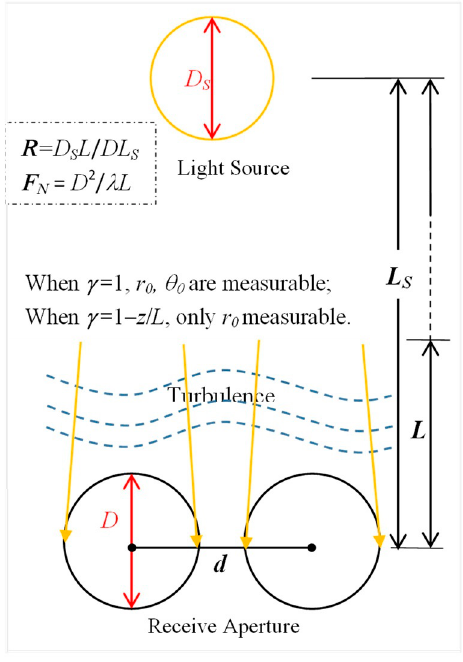
Figure 1. The geometry and variables for the covariance functions.